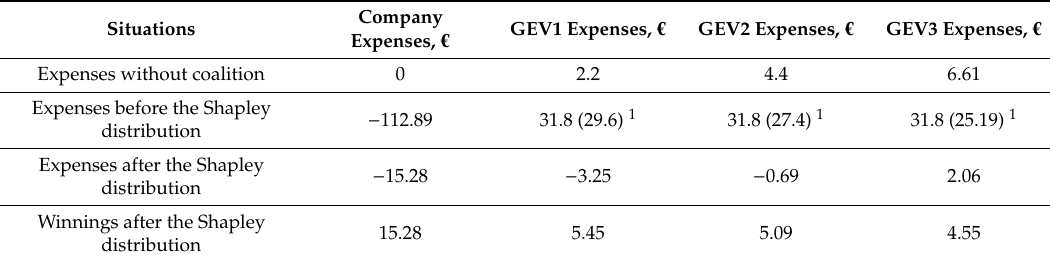
Table 3. Charge/discharge expenses of coalition participants (players), applying the new billing system.